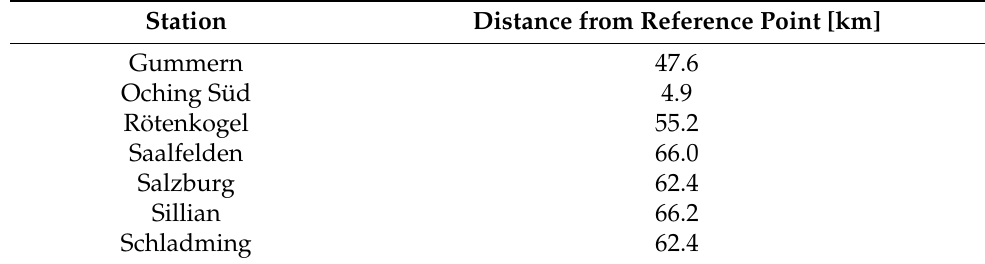
Table 4. Reference stations chosen for SEID processing for